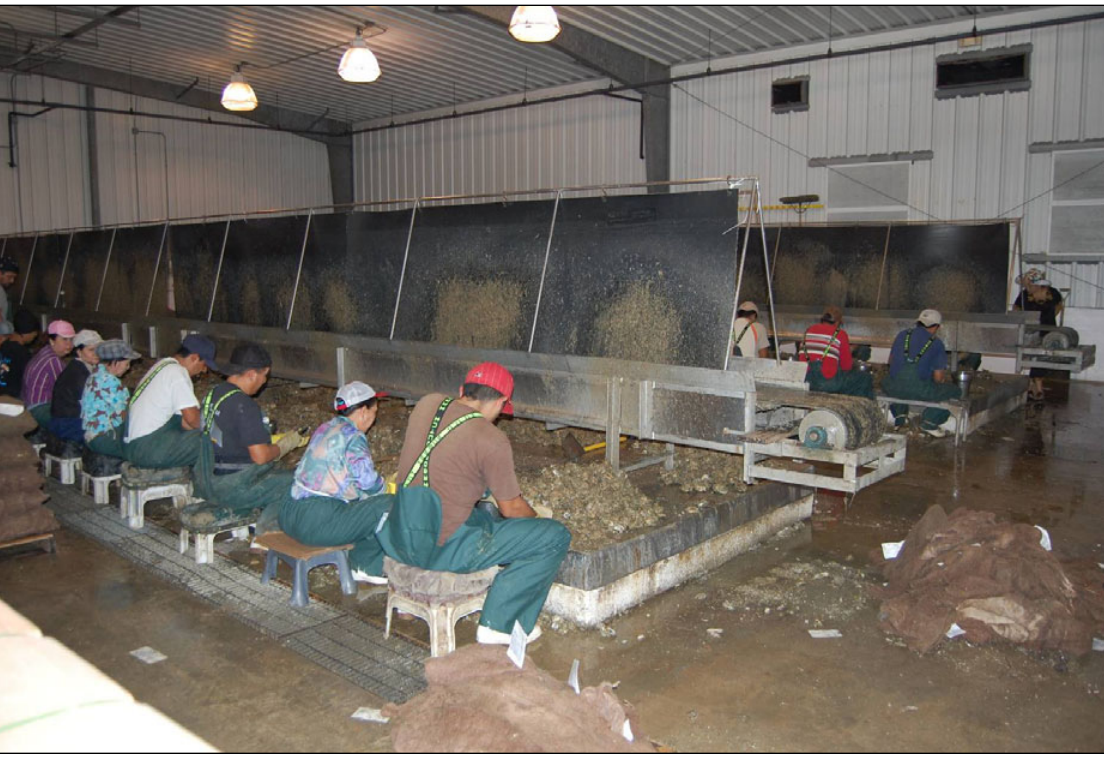
Figure 3. Workers shucking oysters in a Mississippi Gulf Coast seafood processing plant. The shucking process generates significant waste